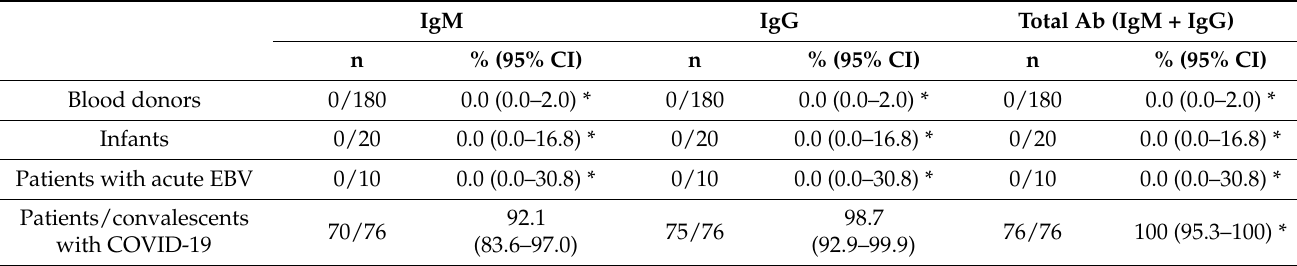
Table 3. Seropositive rate of control sera against S1 protein (aa 16-685) of